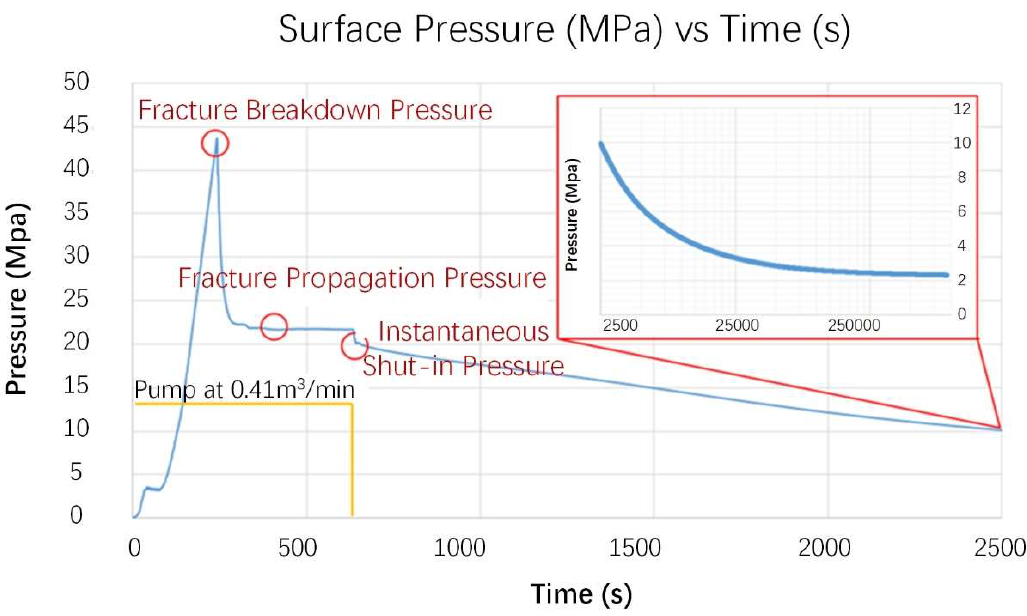
Figure 7. Well-A DFIT pressure and pump schedule. The inserted images show pressure vs. time in semi-log plot.